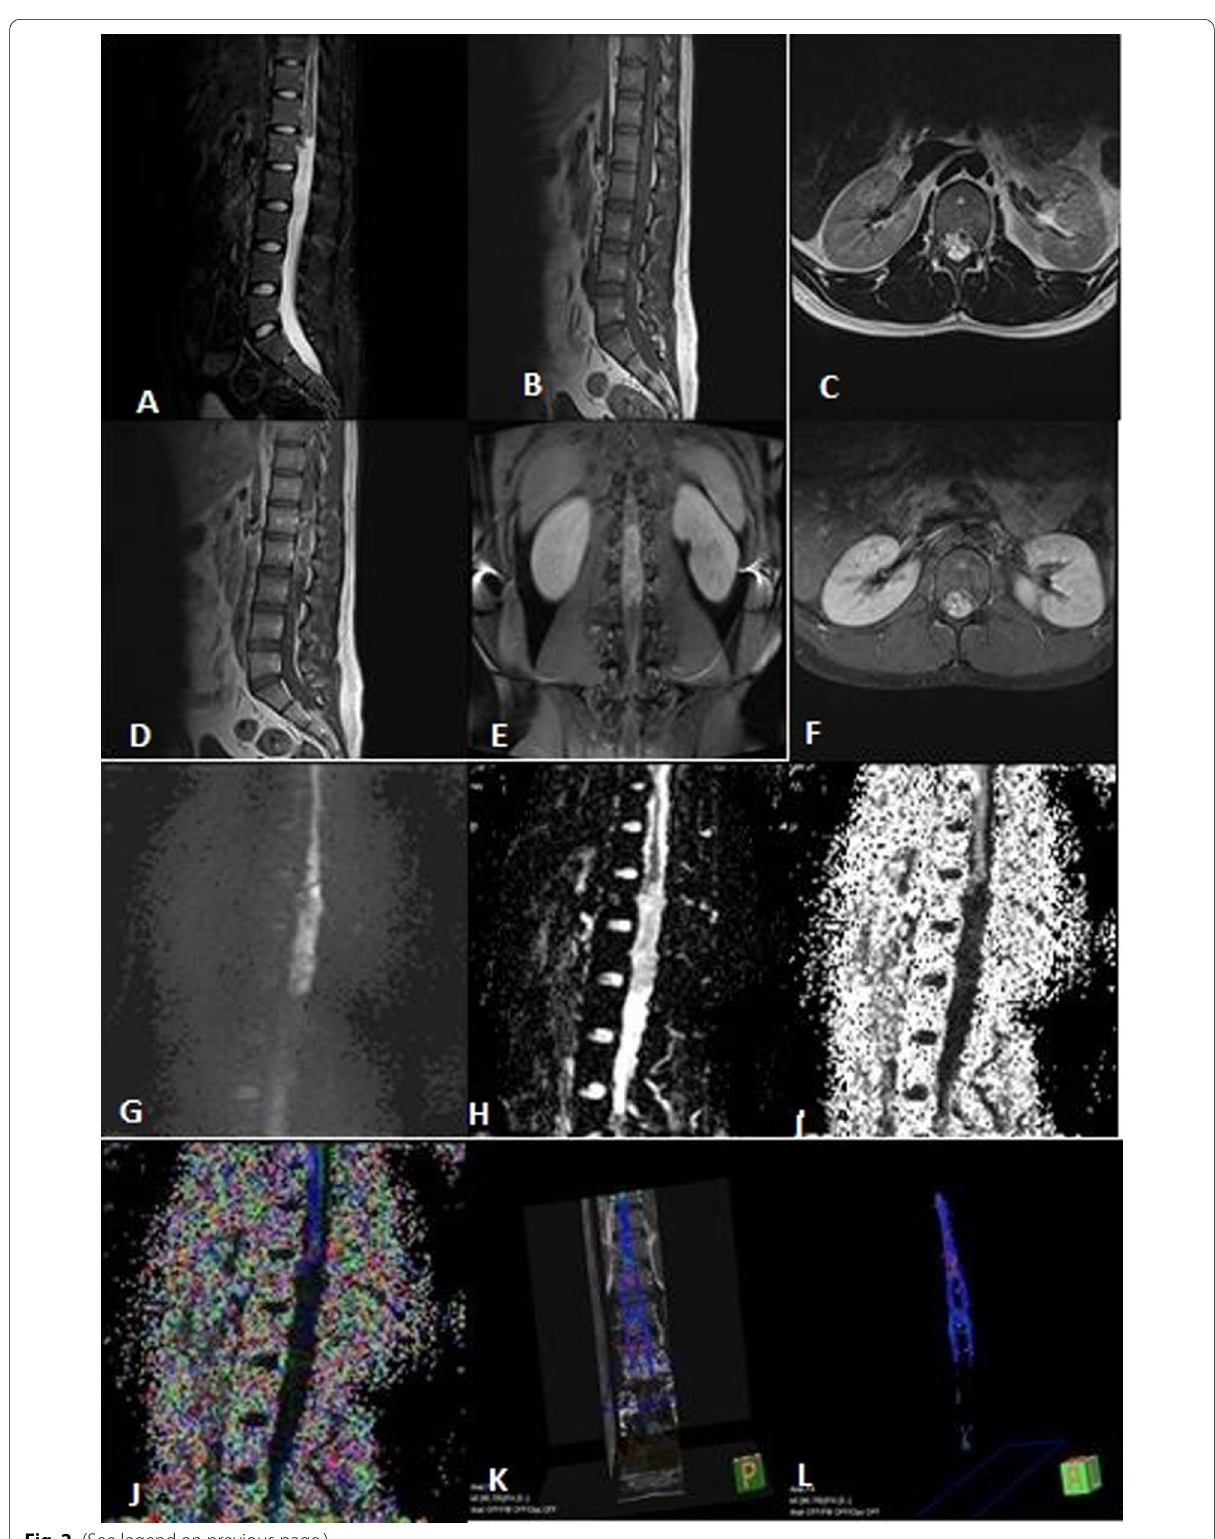
Fig. 2 (See legend on previous